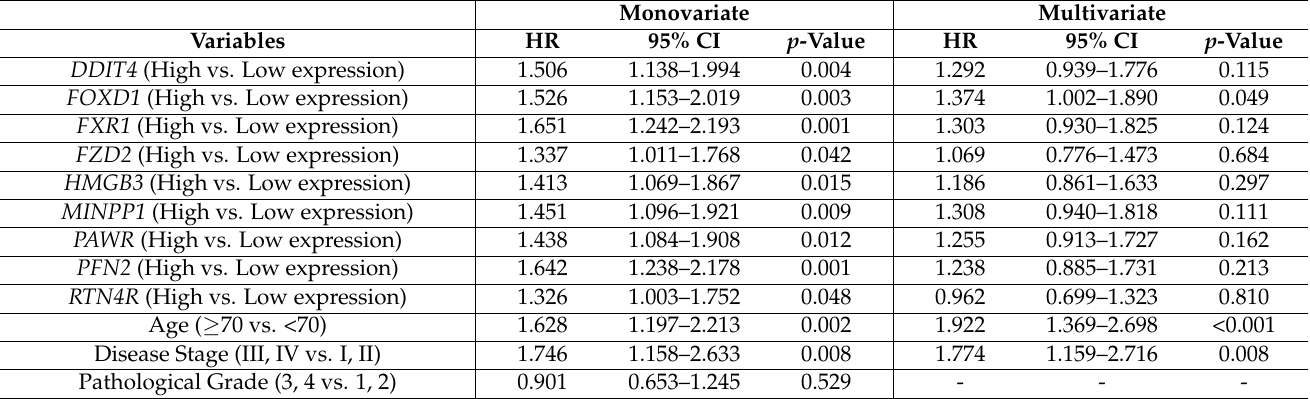
Table 2. Results of Cox regression analysis of overall survivals in five years in TCGA-HNSC. Monovariate